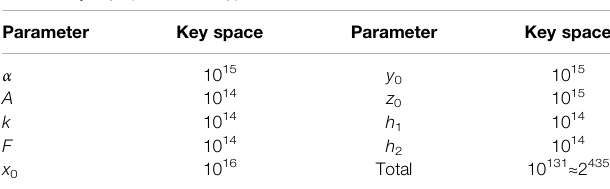
TABLE 1 | Key space of encryption scheme. Parameter